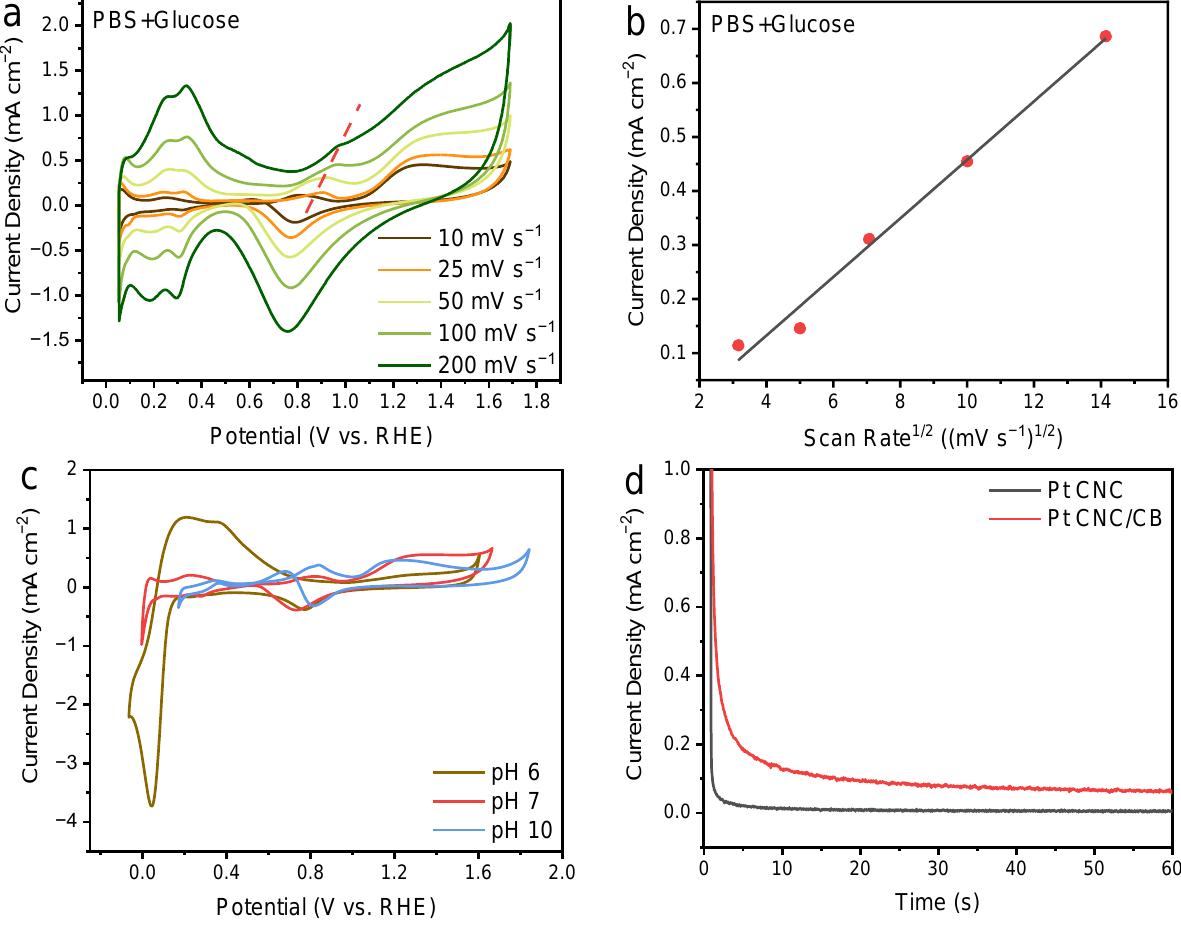
Figure 5. CV curves of Pt CNC/CB in the 0.1 M PBS (pH 7.4) and 50 mM glucose electrolyte at different scan rates (v = 10, 25, 50, 100, and 200 mV s −1 ) ( a ); scan rate dependence of the current density for Pt CNC/CB in the 0.1 M PBS (pH 7.4) solution with 50 mM glucose ( b ); CV curves of Pt CNC/CB in the 0.1 M PBS solution with 50 mM glucose at different pH values (pH = 6, 7, and 10) ( c ); CA curves of the Pt CNC/CB electrode at 1.279 V in the 0.1 M PBS (pH 7.4) and 50 mM glucose electrolyte ( d ).